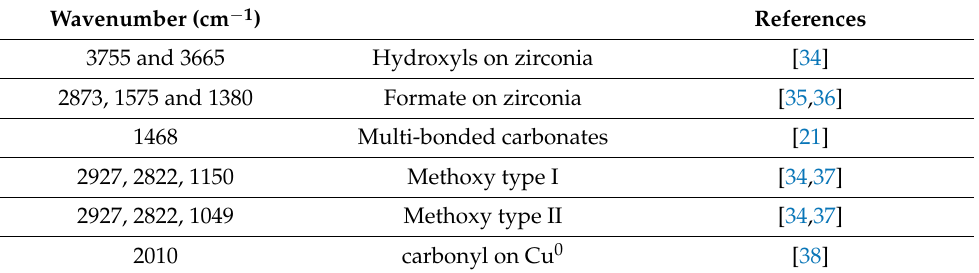
Figure 3. ( A ) Operando DRIFTS spectra collected at steady state 220 °C and 3 bar under (black, top) 20% CO 2 + 60% H 2 and (red, bottom) 25% CO + 75% H 2 . ( B ) (Black) same as (A, black, top) and (Red) in situ DRIFTS spectra collected at 220 °C and 3 bar under H 2 /He after having removed CO 2 from the feed for 60 min. Inset: region used to integrate the formate signal. Table 1. Tentative IR band assignments.